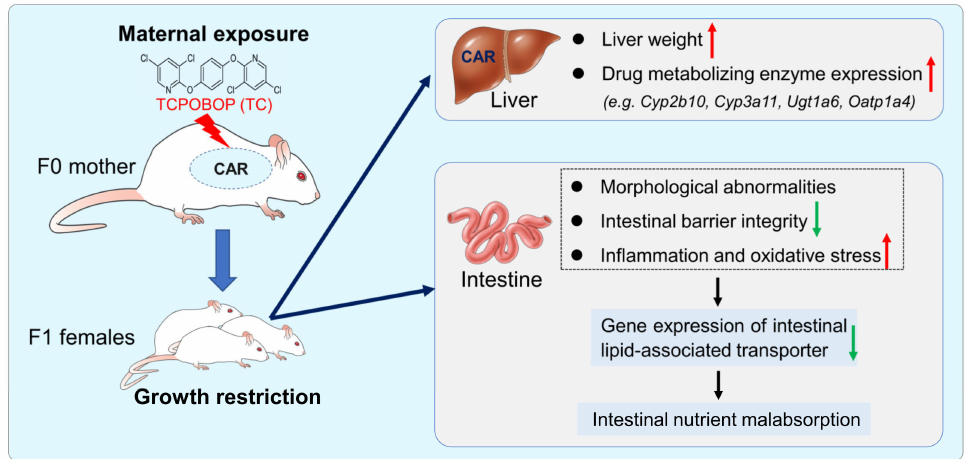
Figure 7. Schematic illustration of maternal TC exposure and offspring health. Maternal exposure to TC resulted in decreased body weight and upregulated expression of drug-metabolizing enzymes in the liver of 3-week-old and 8-week-old F1 female mice. In addition, TC exposure during early life resulted in abnormal small intestinal structure and impaired mucosal barrier in 8-week-old F1 female mice, stimulating slight inflammation and oxidative stress in the intestine. Accordingly, the ability of the intestine to absorb lipids was diminished in the 8-week-old female mice in the TC-exposed group, which led to growth restriction in the offspring. Red arrows indicate up-regulation, and green arrows indicate